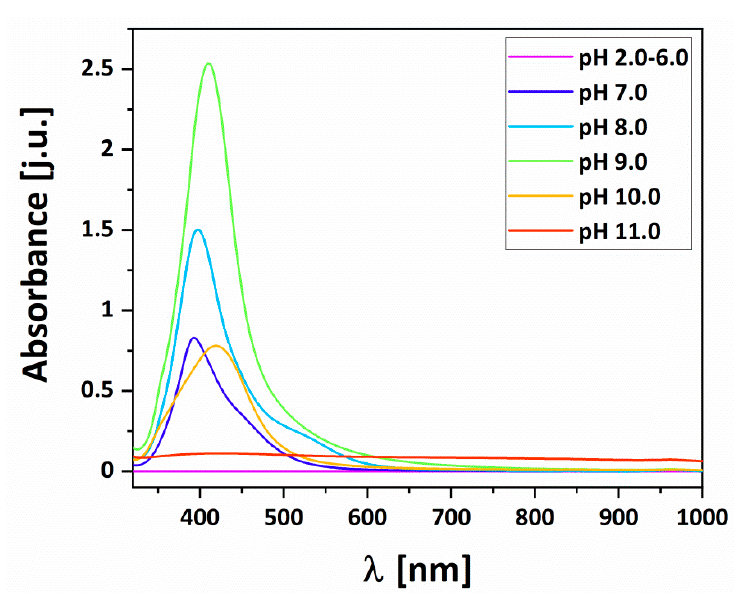
Figure 6. UV-Vis spectra of the silver nanoparticles reduced by malic acid at pH 2.0 to 11.0 in 1:1 dilution with deionized water.